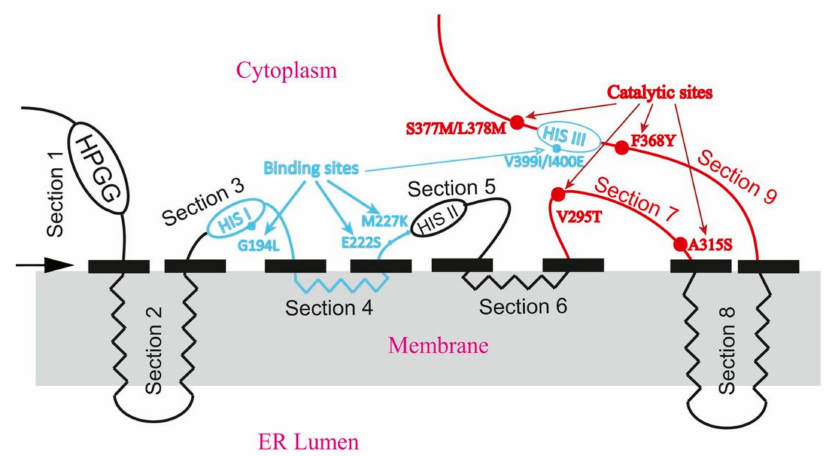
Figure 3. The predicted topology model of ∆ 6 Fads2. The black solid rectangles indicate boundaries of domains. Four alpha-helices span the membrane. The blue lines and blue dots indicate the areas and sites implicated in substrate specificity, red lines and red dots indicate the areas and sites important for catalytic activity, respectively. ER lumen: endoplasmic reticulum lumen. HIS I, HIS II and HIS III: histidine rich motifs. Modified from (Shi et al.,